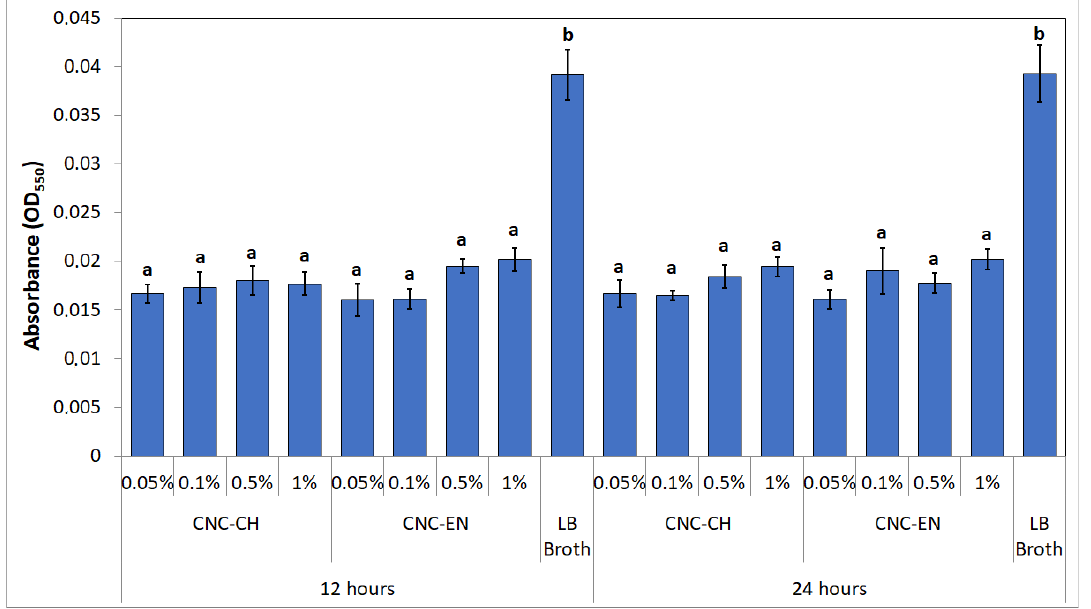
Figure 11. Biofilm production at 12 and 24 h. Data represent the mean and standard deviation; different letters show significantly different values after one- way ANOVA, followed by Tukey’s HSD post hoc test ( p < 0.05 ).